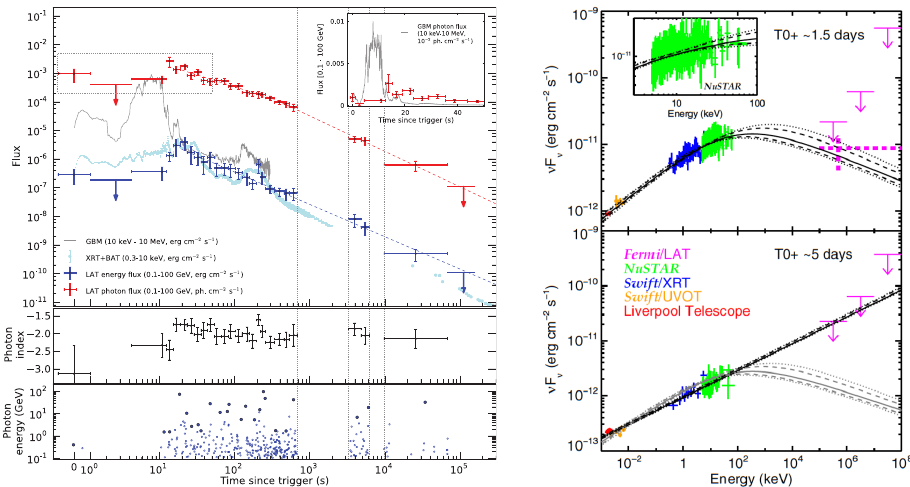
Fig.2.TemporallyextendedLATemission. Top:LATenergyflux(blue) abilities>90%ofbeingassociatedwiththeGRB( 17 ).Solidcirclescor- respondtothephotonwiththehighestenergyforeachtimeinterval.Note andphotonflux(red) light curves. The photonfluxlightcurveshowsa that the photons plotted here are “ source ” class photons, whereas the significantbreakatafewhundredseconds(reddashedline),whereasthe photonsinFigs.1and3are “ transient ” classphotons( 17 ).Theverticalgray energyfluxlightcurveiswelldescribedbyasinglepowerlaw(bluedashed Figure 5. Left : Temporally extended Fermi -LAT emission (from [121], Reprinted with permission linesindicatethefirsttwotimeintervalsduringwhichtheburstwasocculted line).The10keVto10MeV(GBM,gray)and0.3to10keV(XRT+BAT,light byEarth.AstheautonomousrepointrequestmovedthecenteroftheLAT blue)energyfluxlightcurvesareoverplotted.Theinsetshowsanexpanded fieldofviewtowardtheGRBposition,theeffectivecollectingareainthat viewofthefirst50swithalinearaxes,withthephotonfluxlightcurvefrom from AAAS). Top : LAT energy flux (blue) and photon flux (red) light curves. The photon flux light directionincreased,sothatafter~100stherateofphotonsincreasedeven theGBM(inunitsof10 – 2 photonscm – 2 s – 1 )plottedingrayforcomparison. thoughtheintrinsicfluxdecreased. Middle:LATphotonindex.Bottom:Energiesofallthephotonswithprob- curve shows a significant break at a few hundred seconds (red dashed line), whereas the energy flux light curve is well described by a single power law (blue dashed line). The 10 keV to 10 MeV (GBM, gray) and 0.3 to 10 keV (XRT + BAT, light blue) energy flux light curves are overplotted. Middle : LAT photon index. Bottom : Energies of all the photons with probabilities > 90% of being associated with the GRB. Solid circles correspond to the photon with the highest energy for each time interval. The vertical gray lines indicate the first two time intervals during which the burst was occulted by Earth. Right : A smoothly broken power-law synchrotron afterglow model [25] fit to the optical to GeV spectrum of GRB 130427A (from [137], ©AAS. Reproduced with permission). Broadband SEDs are shown during the first ( top panel) and the second ( bottom panel) NuSTAR epochs. The Fermi LAT upper limits are shown as arrows, and the extrapolation of the LAT flux light curve is shown as a dashed magenta cross (only during the first epoch). The second epoch ( bottom panel) is fit with a power law (black line); the fit to the first epoch is scaled down and superposed on the second epoch data for comparison (in